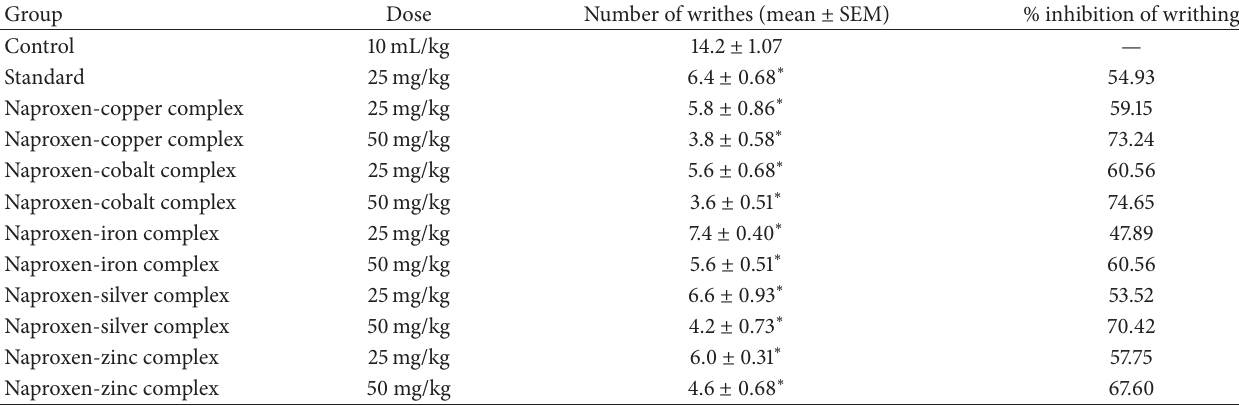
Table 1: Effects of naproxen and its metal chelates on acetic acid-induced writhing response in